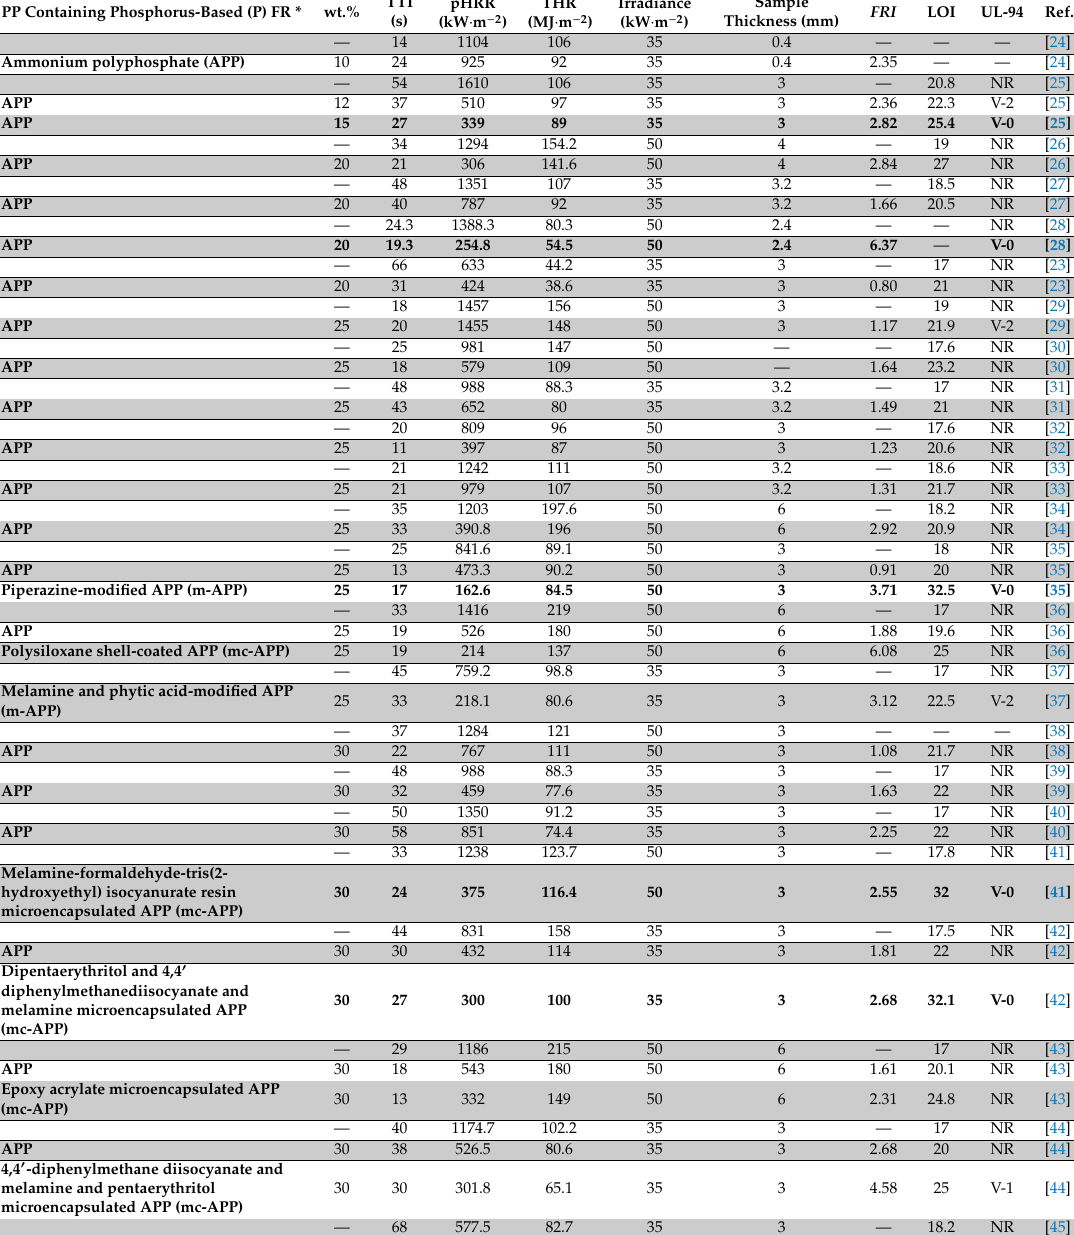
Table 1. Flame-retardant PP materials containing phosphorus-based (P) flame retardants. Data are extracted from the literature: cone calorimetry parameters (TTI, pHRR, THR), LOI, and UL-94 values. The FRI values were calculated by authors of the present review. The name and the percentage of flame retardants are provided in separate columns. “wt.%” was used for loading level of additives, while “—” stands for the systems free of additive or the neat PP. * FR means flame retardant. Since all comparisons were made in terms of FRI , classification of polymers in terms of their flame retardant properties was not surveyed based on the chemistry of additives, heat flux, sample thickness, etc. PP Containing Phosphorus-Based (P) FR *